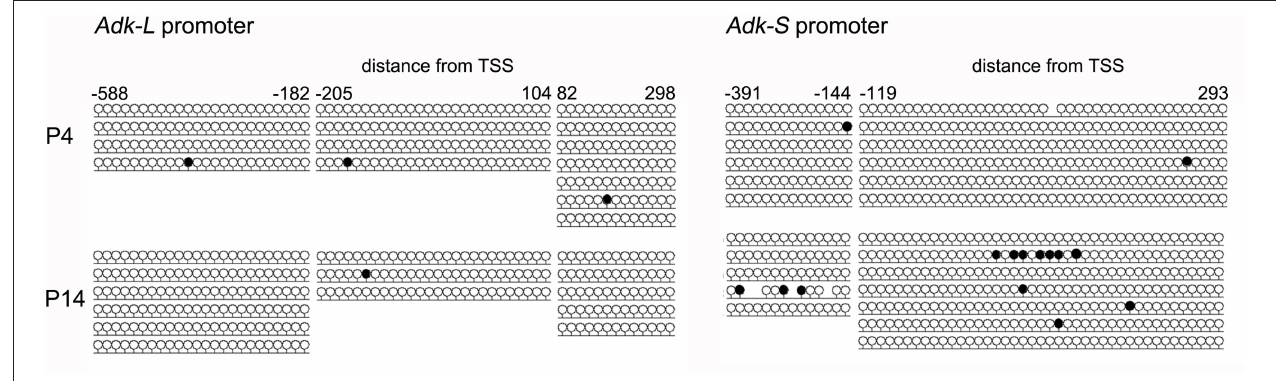
FIGURE 4 | DNA promoter methylation. CpG methylation was analyzed using bisulfite sequencing following amplification and subcloning of the region of interest. A minimum of three clones was analyzed per sample. Promoter regions were amplified from pos. − 588 to + 298 (long isoform) and pos. − 391 to + 293 (short isoform) relative to